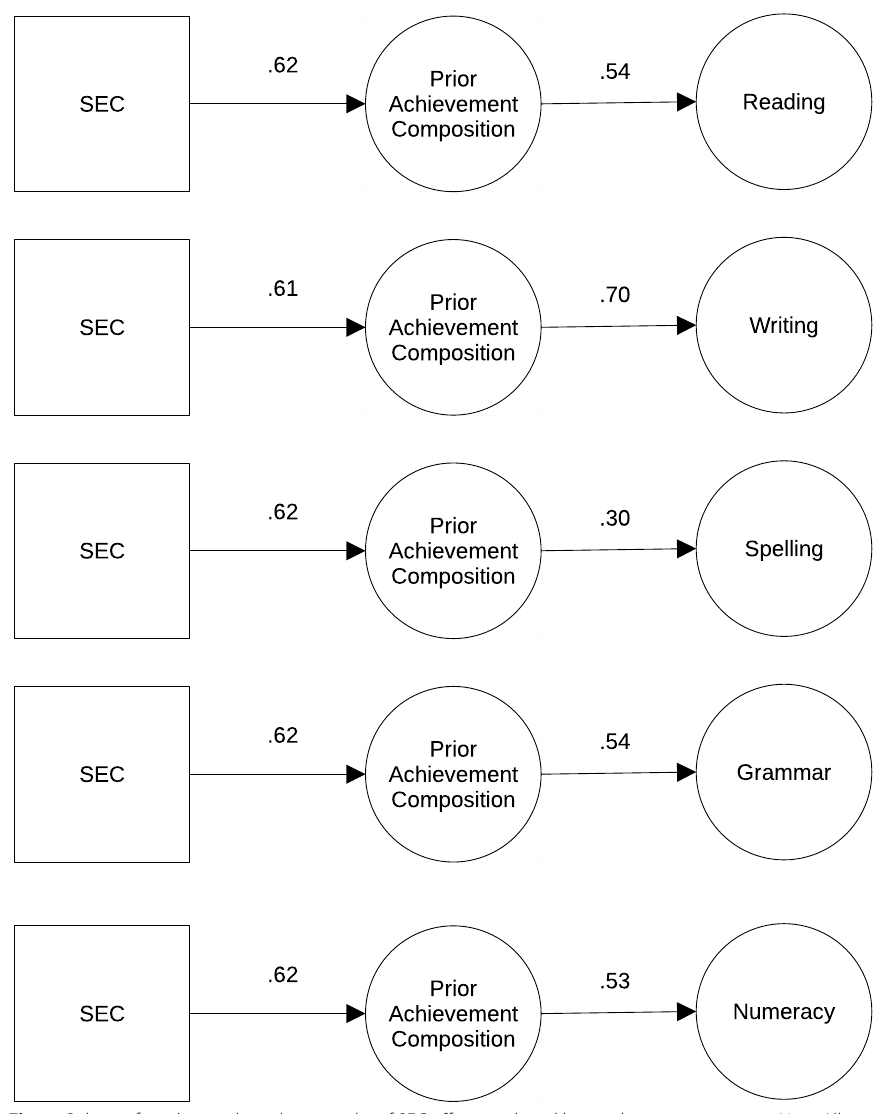
Fig. 4 Subset of grade 5 path analyses results of SEC effect mediated by academic composition. Note . All p < 0.001 unless * p < 0.05 or ** p < 0.01 or NS (not